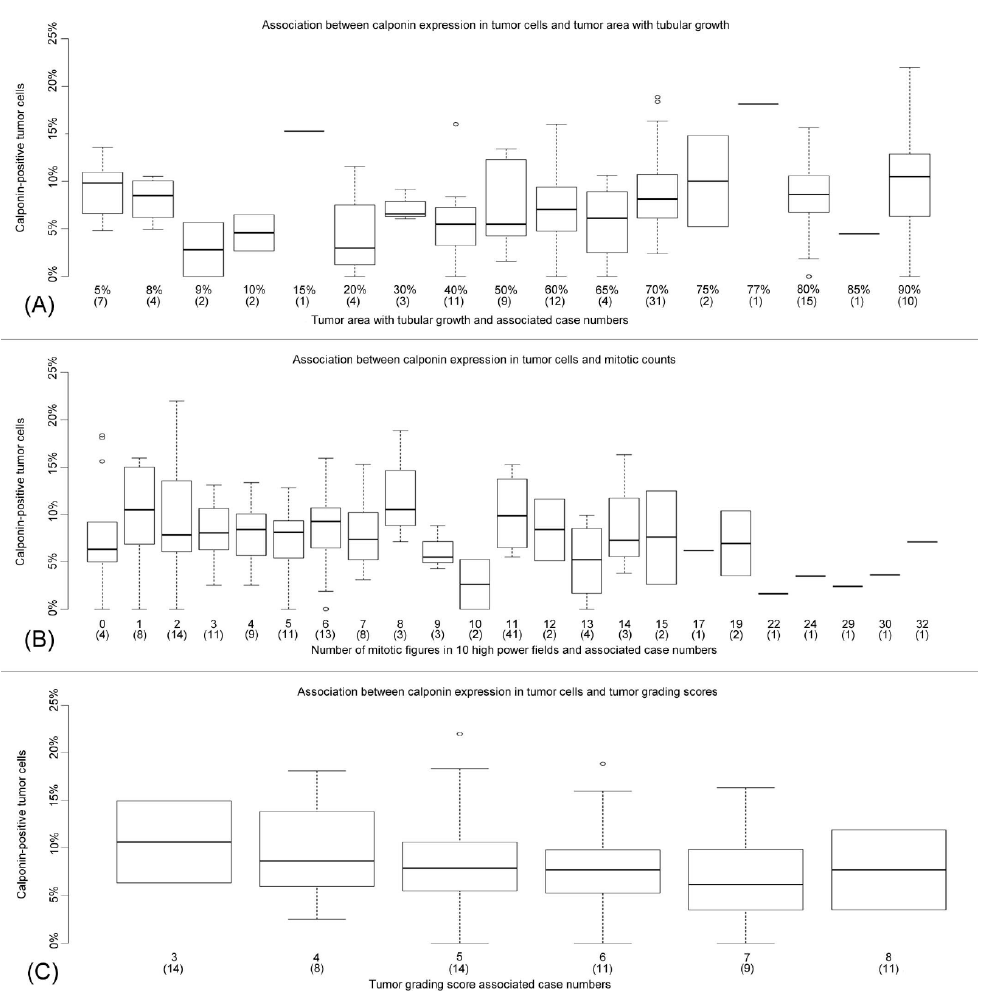
Figure 4. This figure shows the association between the percentages of calponin-positive tumor cells and the tumor area with tubular growth ( A ), the number of mitotic figures in 10 high power fields ( B ), and the tumor grading score ( C ). The numbers in parentheses indicate the number of cases for each category of tubular growth, the different mitotic counts, and the individual grading scores,